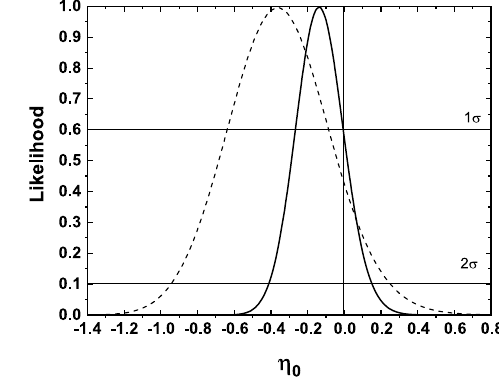
Fig. 1 Left : Smooth plot of fgas versus redshift obtained after apply- ing Gaussian process.The red line shows the best fit line while dark and light regions are the 1 σ and 2 σ confidence bands respectively. Right :